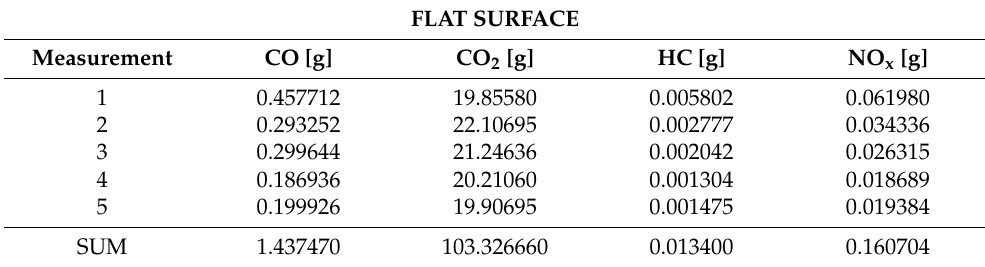
Table 4. Exhaust gas composition for five selected accelerations—flat surface. Source: author.